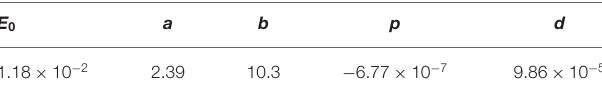
TABLE 1 | The model parameters used for this work for the intensity seen by an individual photosensor (Equation 2) with ρ in the unit of